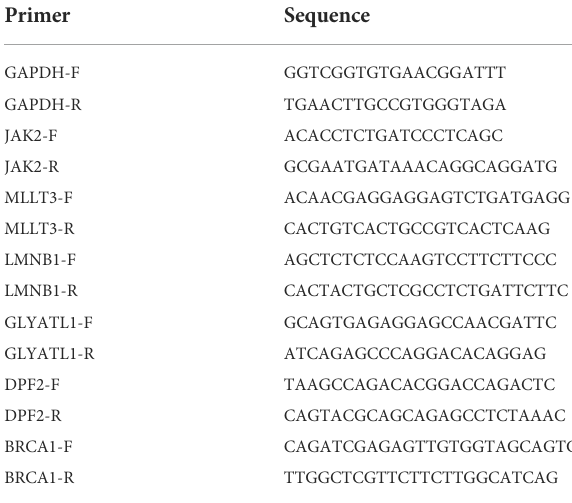
TABLE 2 Speci fi c primers used for quantitative real-time